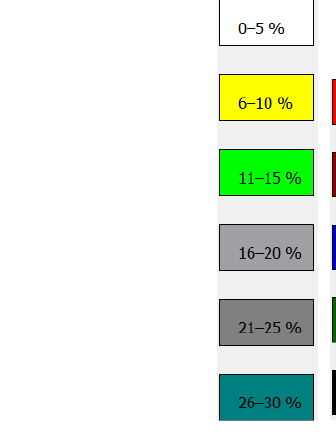
Figure 4. Contagious Diffusion in a Plain Space, for t = 34, 52, 65, 73, 78, 87.